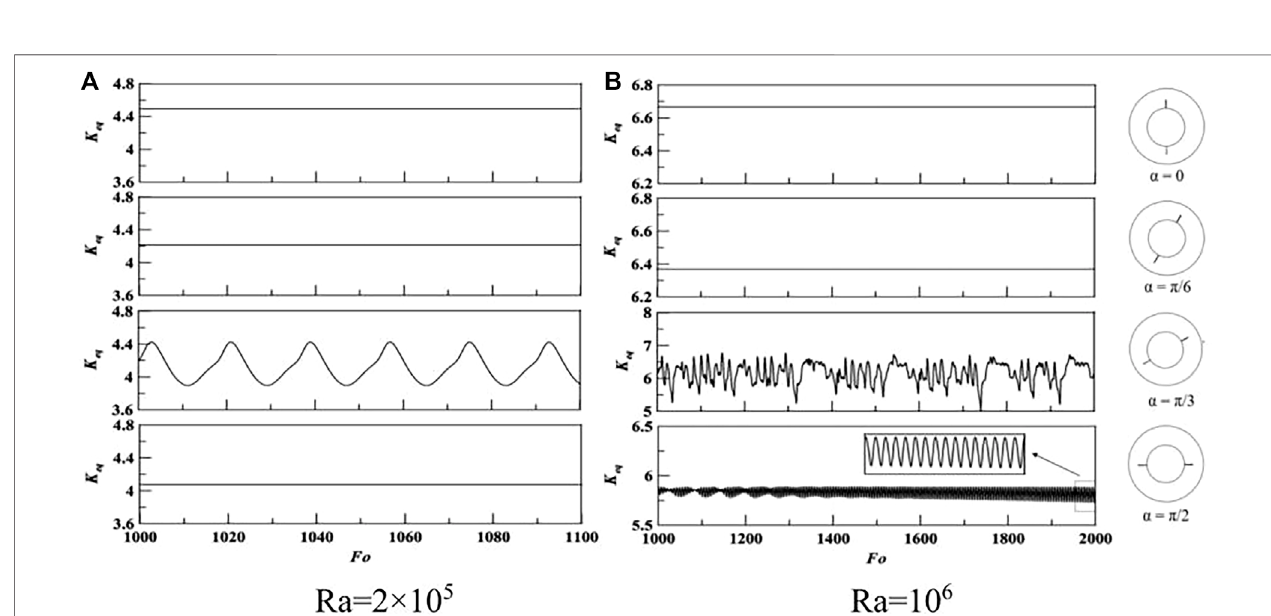
Frontiers in Energy Research |